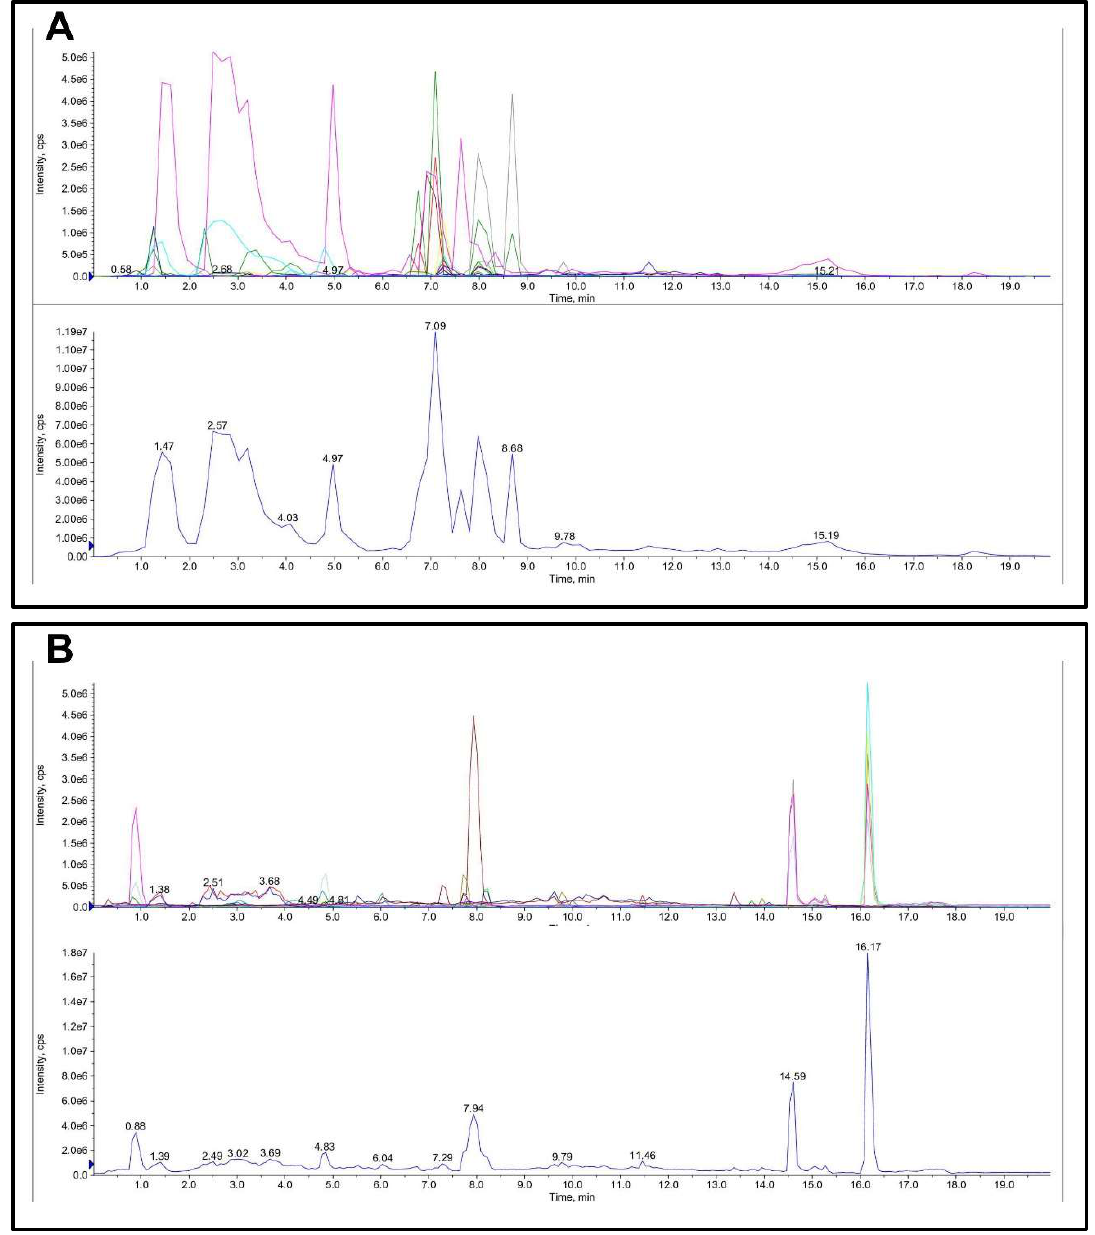
Figure 4. Total ion chromatogram (TIC) of FML in LC-MS/MS: ( A ) ESI ; ( B ) ESI+.